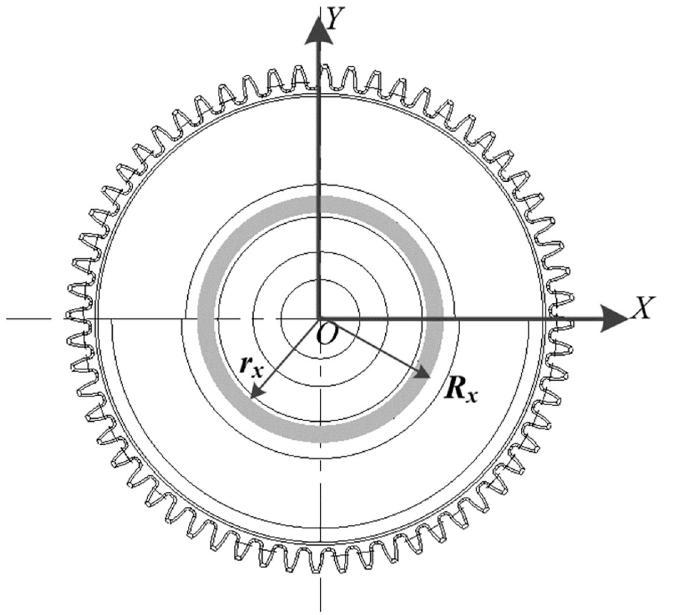
Fig 8. Plane characteristics of rubber ring